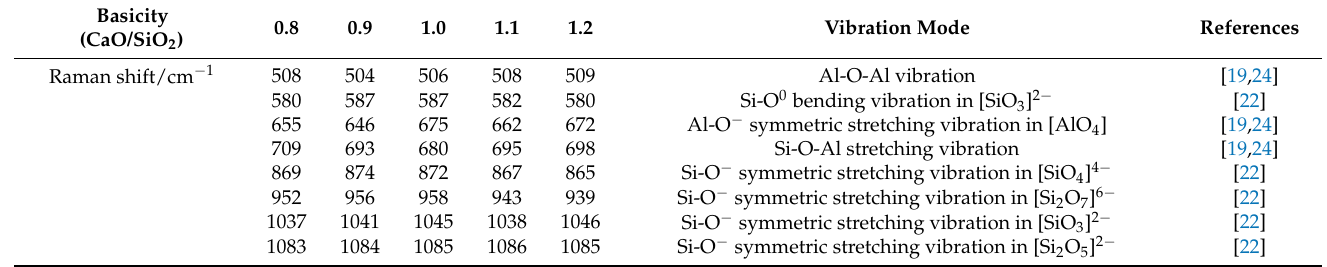
Figure 8. Raman spectra of glassy phase samples with different basicity. Table 4. Glassy phase characteristic peak positions and reference data for different R